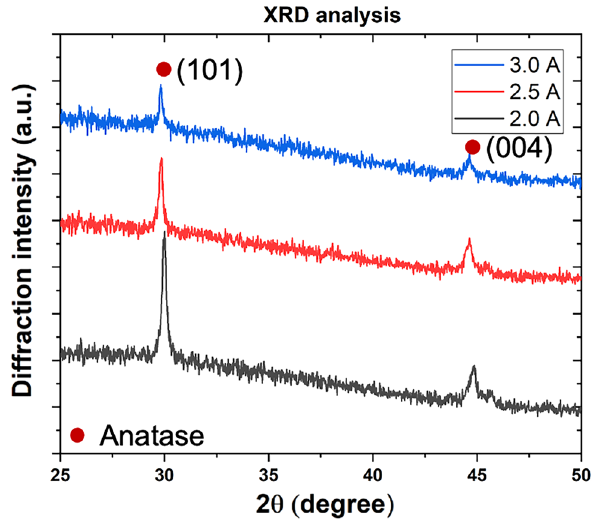
Figure 7. XRD diffractograms of TiO 2 /Au-np nanocomposite films synthesized with increasing the matrix deposition rate via the current intensity applied on Ti